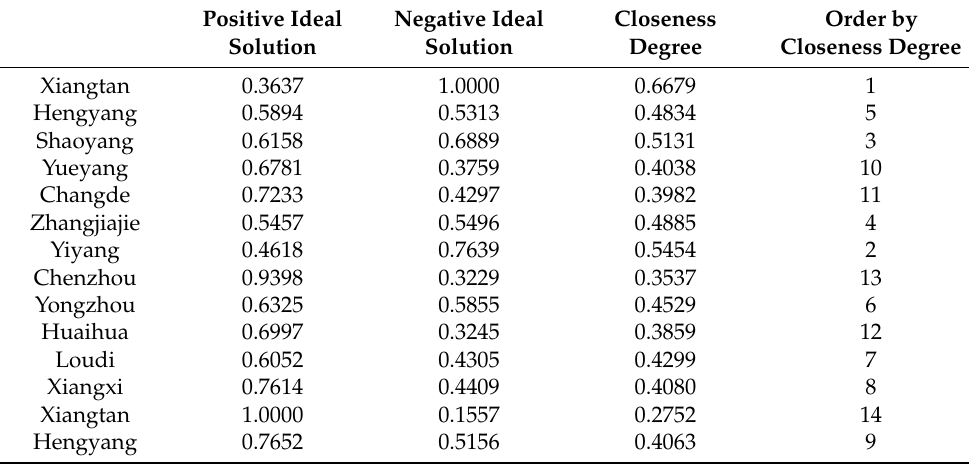
Table 4. Evaluation results of grassroots water services in Hunan